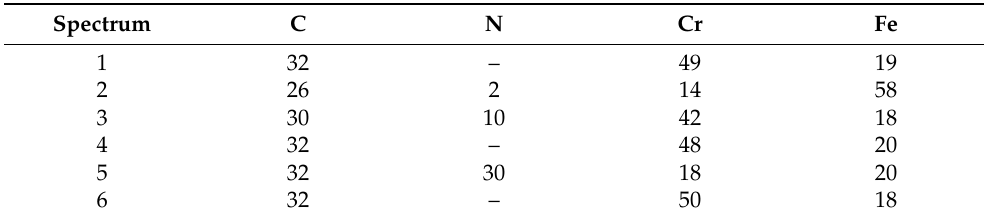
Table 7. Semi-quantitative analysis of phases shown in Figure 5b. This analysis was carried out through an energy dispersive X-ray microanalysis (EDX). (%